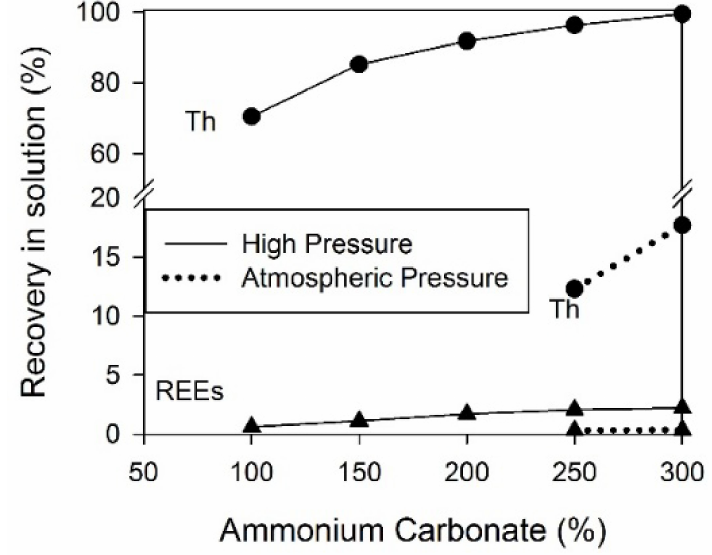
Figure 2. E ff ect of the pressure on the recovery of thorium (Th) and REE at 70 ◦ C, adapted from [31]. (Reproduced with permission from ref. [31], copyright (2002), Elsevier)